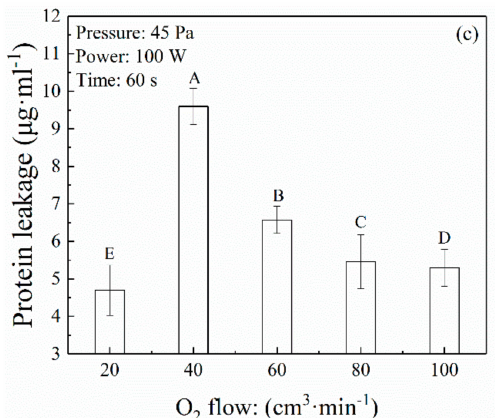
Figure 4. Quantity of protein leakage under di ff erent treatment conditions. ( a ) Time 60 s, O 2 flow 40 cm 3 · min − 1 , Pressure 45 Pa; ( b ) Power 100 W, O 2 flow 40 cm 3 · min − 1 , Pressure 45 Pa; ( c ) Power 100 W, Time 60 s, Pressure 45 Pa. Capital letters A–E represent statistical significance.